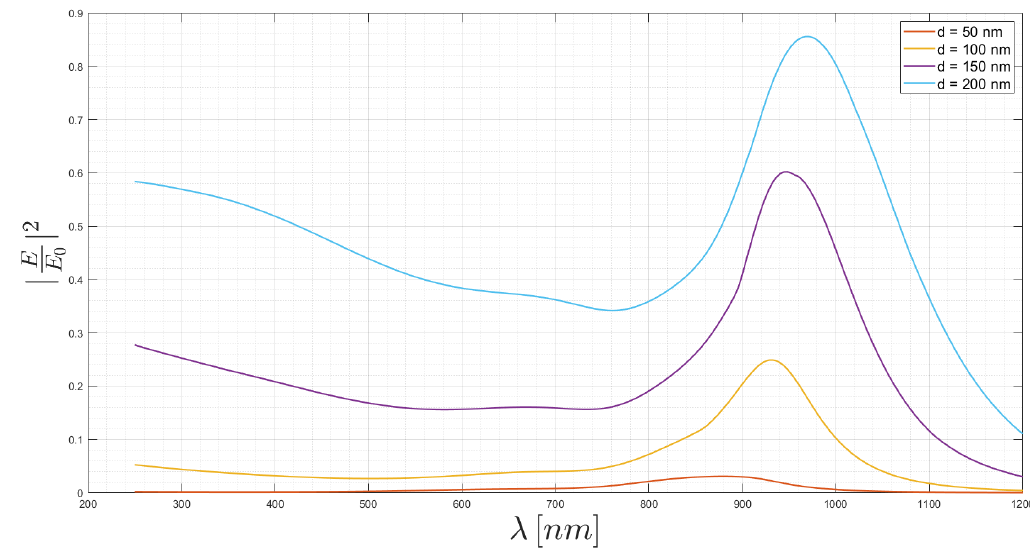
Figure 5. Hole diameter sweep on a gold nanostructure with a quartz substrate.